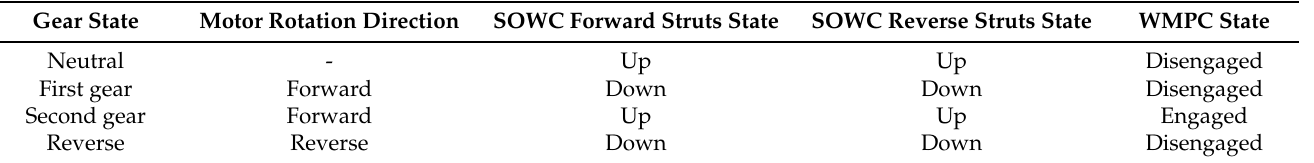
Figure 4. Structure of SOWC. Table 1. Shift table of IW-AMT.